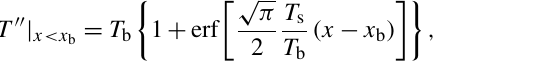
transect and then divided by (cid:49)x after the filter in Eq. (4) is applied. Given the zonally detrended v(cid:49)x and its